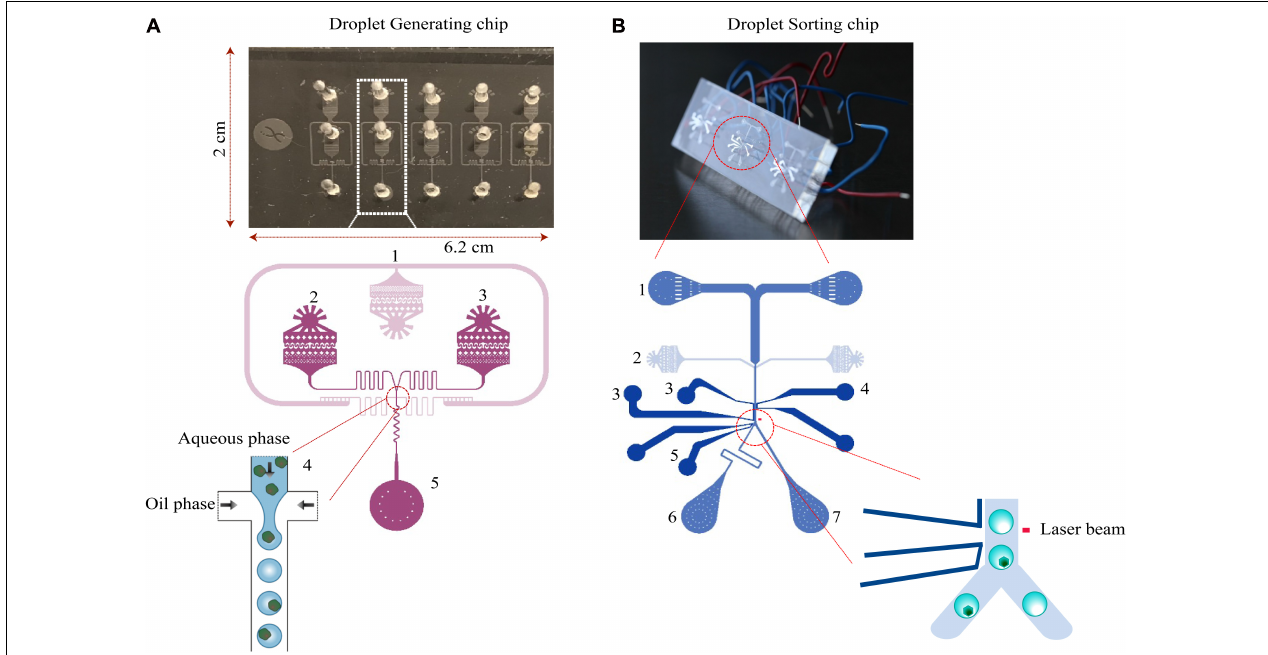
FIGURE 8 | Design of microfluidic chips. (A) The droplet generation chip for cell encapsulation consists of an oil phase inlet (1), and two aqueous phase inlets (2 and 3). The fluid resistors (4) dampen fluctuations arising from the mechanical instability of syringe pumps and PDMS device. Due to the surface tension of the water–oil interface, the aqueous phase breaks up into droplets at the flow-focusing junction. Droplets are collected into a syringe or an Eppendorf tube from the outlet (5). (B) The droplet-sorting chip consists of two inlets for droplets (1) and spacing oil (2). The flow rate ratio of the oil and injected emulsions are varied to control the distance between adjacent droplets. The droplets at the sorting junction are sorted based on the fluorescence intensity. Downstream to the detection, electrodes—ground (3, 4), high voltage (5) are located. Next to the electrodes, the channel is split into two outlets for collecting sorted droplets (6) and unsorted/waste cells